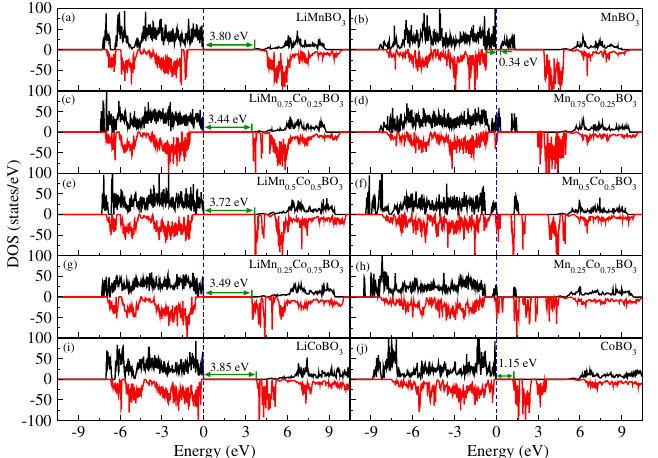
Figure 3. Density of states of fully lithiated ( y = 1 ; left panel) and delitiated ( y = 0 ; right panel) Li y Mn 1 − x Co x BO 3 crystals calculated using GGA + U where U d (Mn)= 4.5 eV and U d (Co)= 5.7 eV. The Fermi level is indicated by a vertical dashed line.